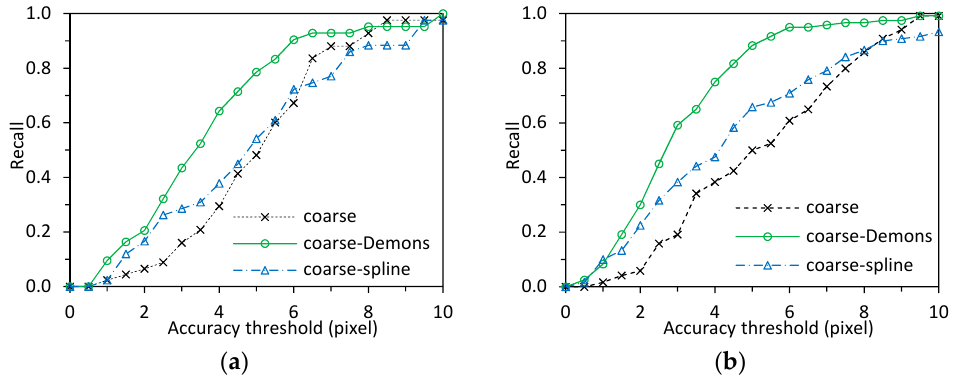
Figure 8. Recall graphs showing image registration accuracy of the coarse, coarse-Demons and coarse-spline models: ( a ) Markers in the face region as the control points based on the subjects in Table 1; ( b ) Landmarks around the eye region as the control points based on the subjects in Table 2. Table 2. Registration Matching Error (Landmarks around the eye region as control points),